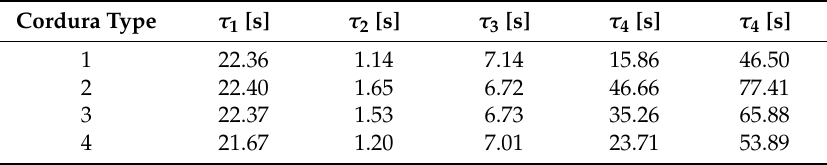
Table 2. Execution times for various algorithm stages in the Matlab environment averaged over 10 sample regions for each Cordura sample. τ 1 , τ 3 —the times of surface and internal boundary filtering, respectively (Figure 9 (1), (6)); τ 2 —the time of surface boundary thresholding and approximation (Figure 9 (2) ÷ (5)); τ 4 —the time of internal boundary thresholding, approximation and thickness computing (Figure 9 (7) ÷